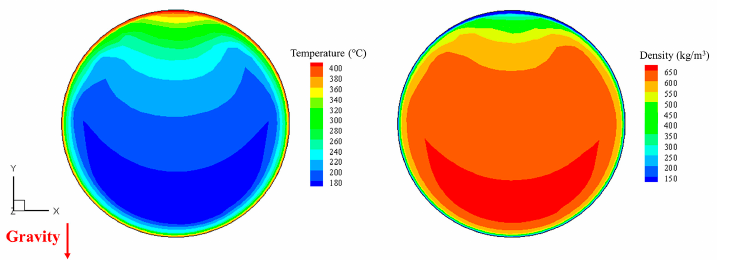
Figure 10. Distribution of temperatures and densities at cross-section Z = 175 mm under 2.5 MPa (numerical results of Case 3).